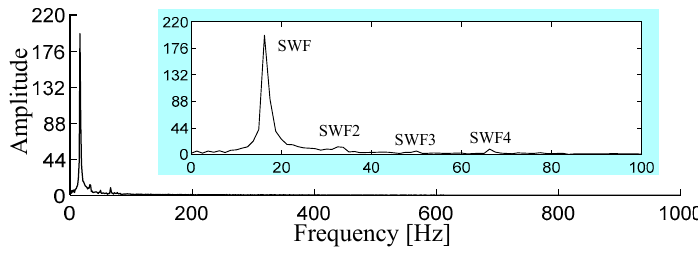
Figure 29. The FFT spectrum of the displacement signal.